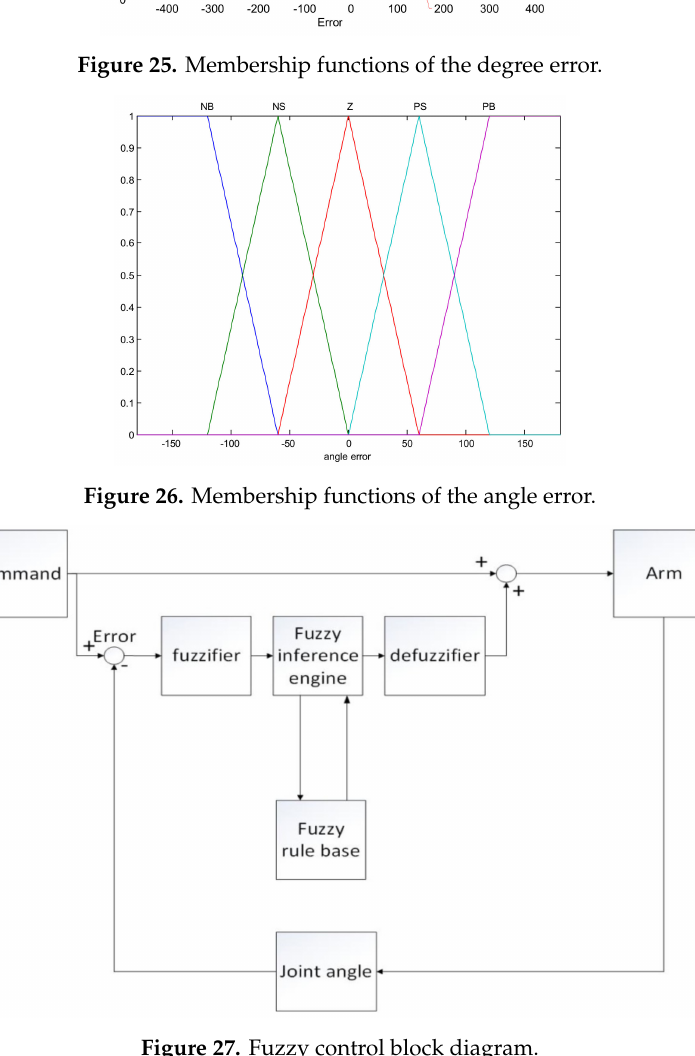
Figure 27. Fuzzy control block